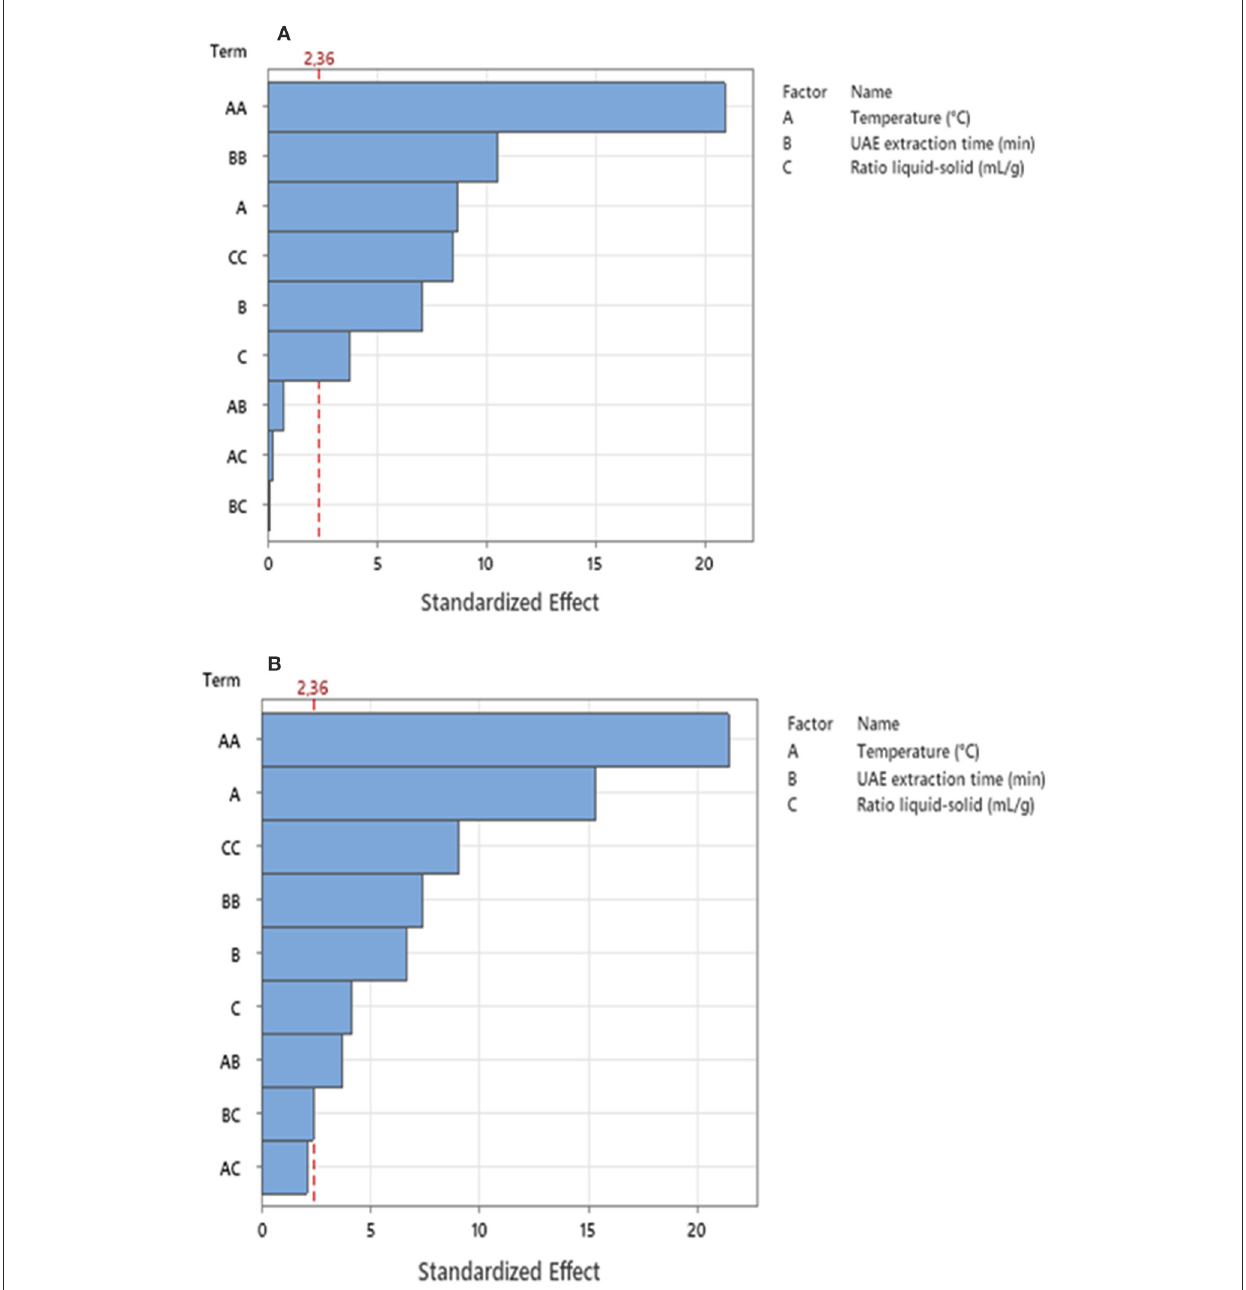
FIGURE1 Pareto chart of the standardized effects ( α = 0.05) in samples (A, B) of Polygonum equisetiforme roots that influenced by several factors temperature, UAE extraction time and ration of liquid-solid.